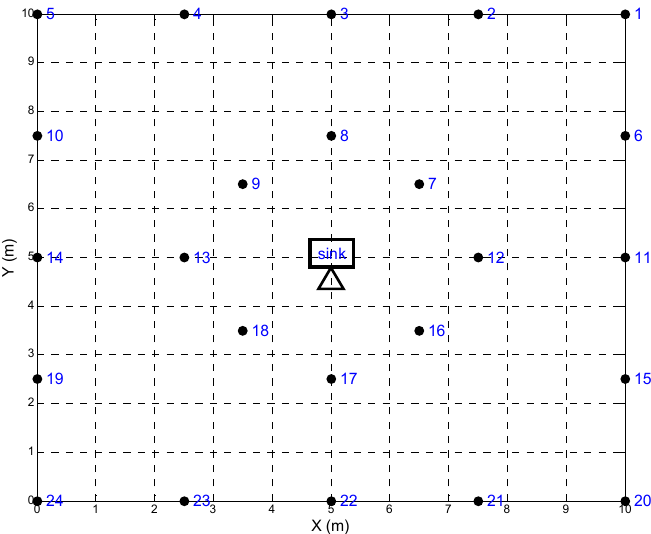
Figure 3. The layout of an energy-harvesting WSN.